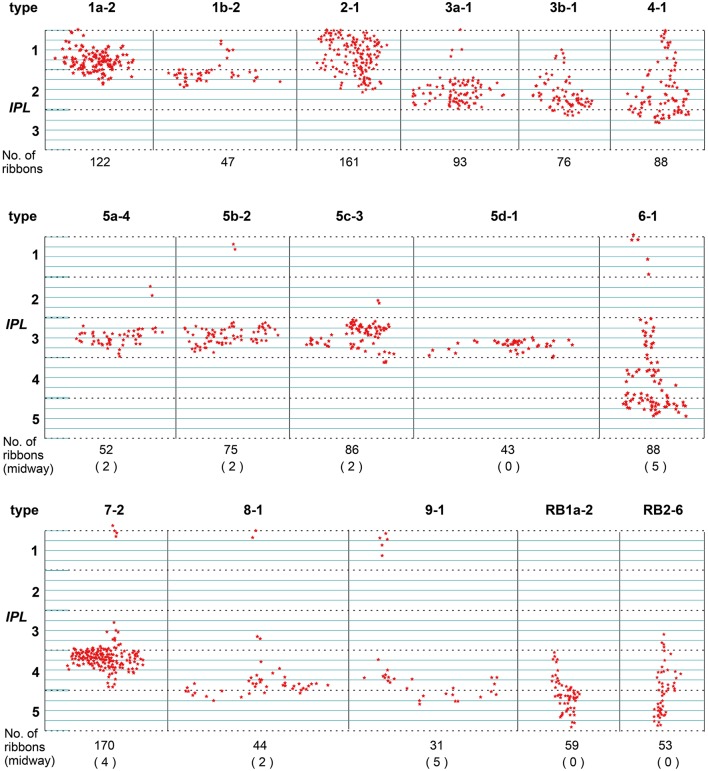
Side view of the axonal ribbons of each type of bipolar cell projected on the vertical plane. Stars each indicate the site of an axonal ribbon synapse with amacrine and/or ganglion cells. The number of axonal (midway + terminal) ribbons is written underneath each cell and the number of only midway ribbons is in each parenthesis. The axonal ribbons of OFF bipolar cells are confined to strata 1 and 2, and the outer half of stratum 3. The axonal ribbons of most ON bipolar cells are categorized into two, a major group of terminal ribbons in the ON sublamina and a minor group of midway ribbons in the OFF sublamina. The terminal ribbons are located largely in stratum 3 for types 5a−5d, strata 3 and 4 for type 7, and strata 3 and 4, and the outer half of stratum 5 for types 8–9. The midway ribbons are located largely in strata 1 or 2 for types 5a−5c and 6–9. The terminal ribbons are confined to the inner half of stratum 3, and strata 4 and 5 for RB1 and RB2. The vertical bin is 2 μm.